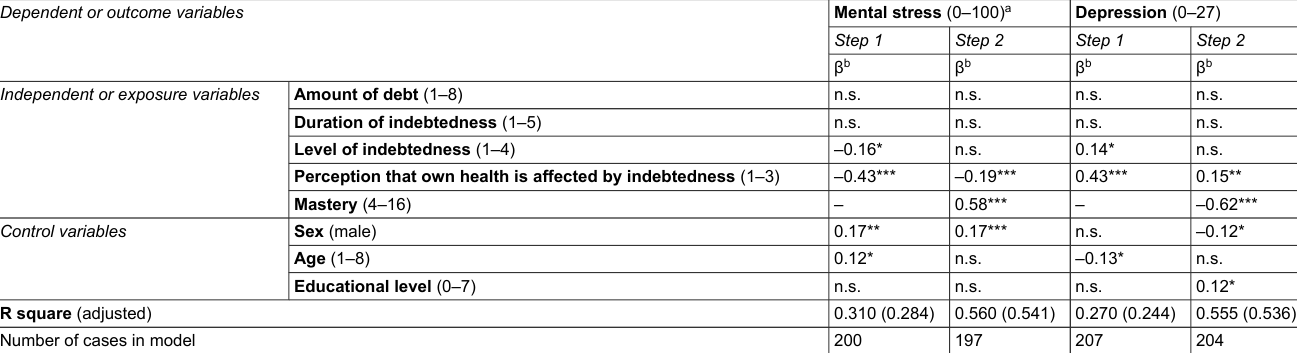
Table 4: Multiple linear regression analyses and multivariate associations of debt and personal characteristics with mental health outcomes in the study population of over-indebted indi- viduals (n = 219). Dependent or outcome